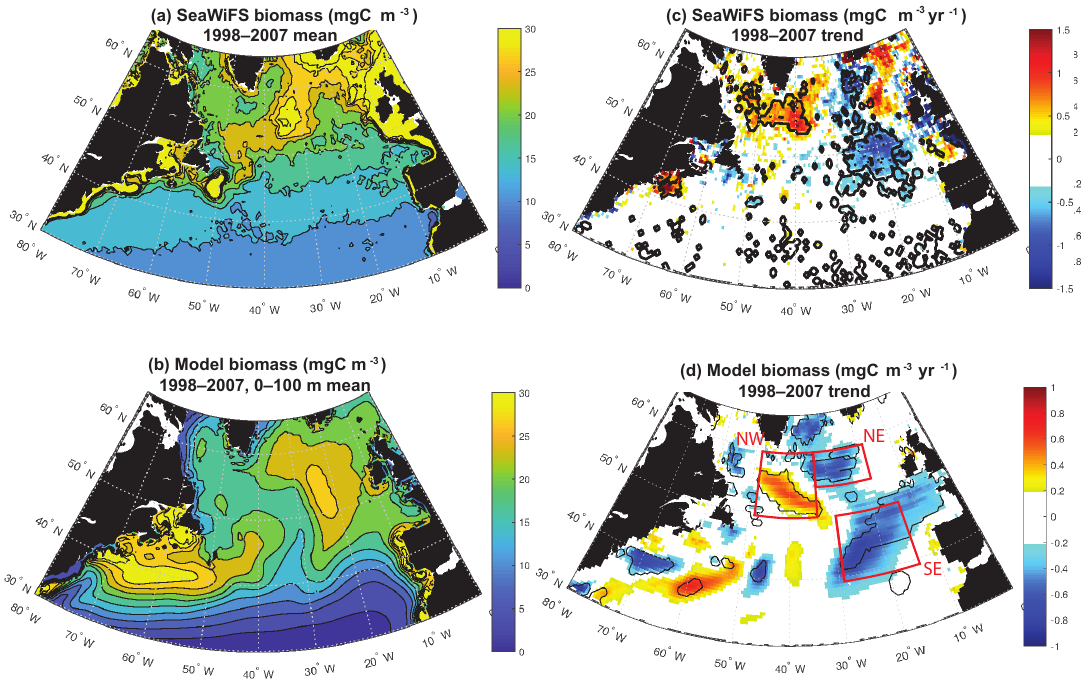
Figure 1. Surface ocean biomass: (a) estimated from SeaWiFS using the CbPM model, (b) 0–100m modeled biomass, (c) SeaWiFS trend 1998–2007, and (d) 0–100m modeled biomass trend 1998–2007. In (c) and (d) , significant trends are marked with a black contour. In (d) , the three focus regions are outlined in